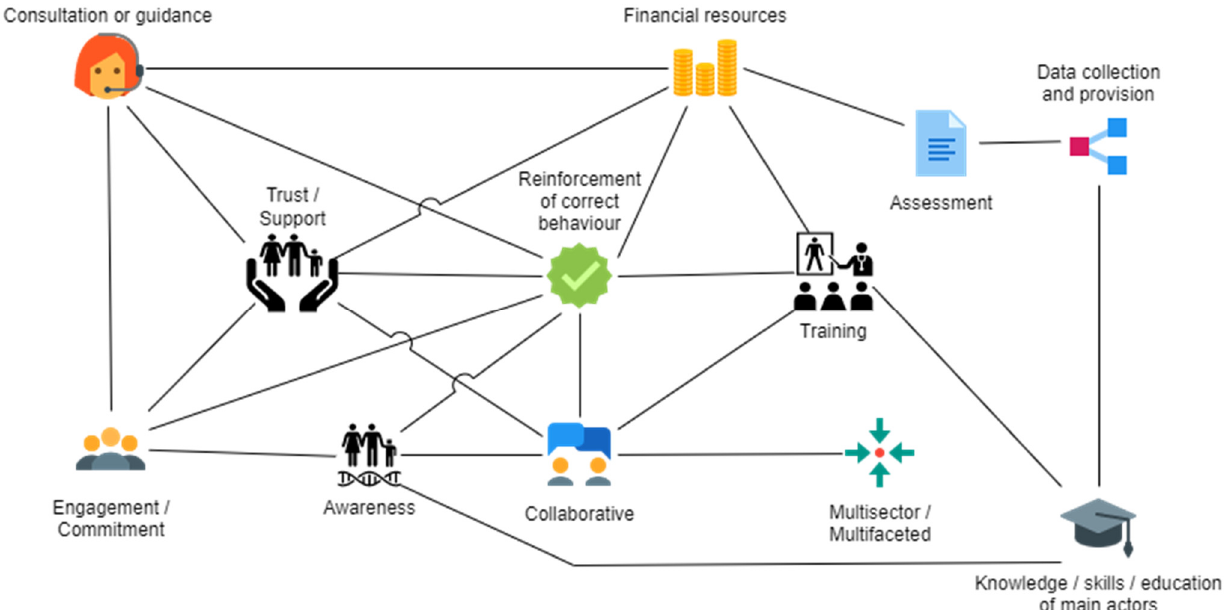
Figure 2. Qualitative map between the 12 most frequent sub-themes in our study. Connections between sub-themes were mapped when those were mentioned together in the same response, which illustrates factors that can be promoted together to enhance success or to positively impact AMR.